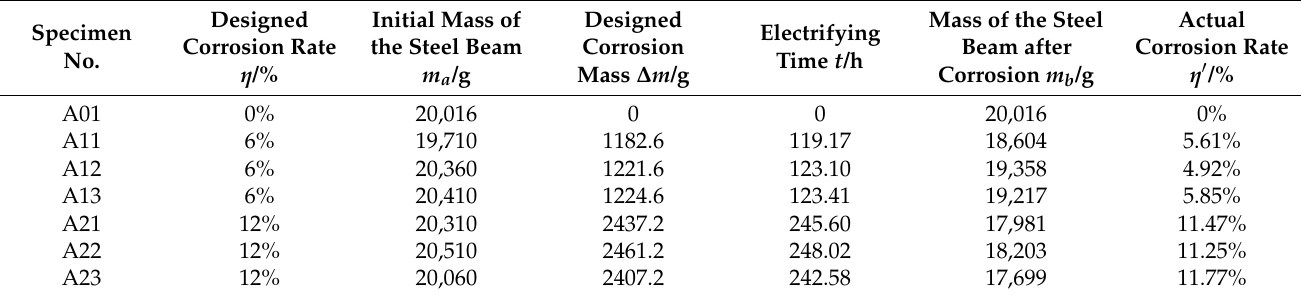
Table 2. Results of the accelerated corrosion test.